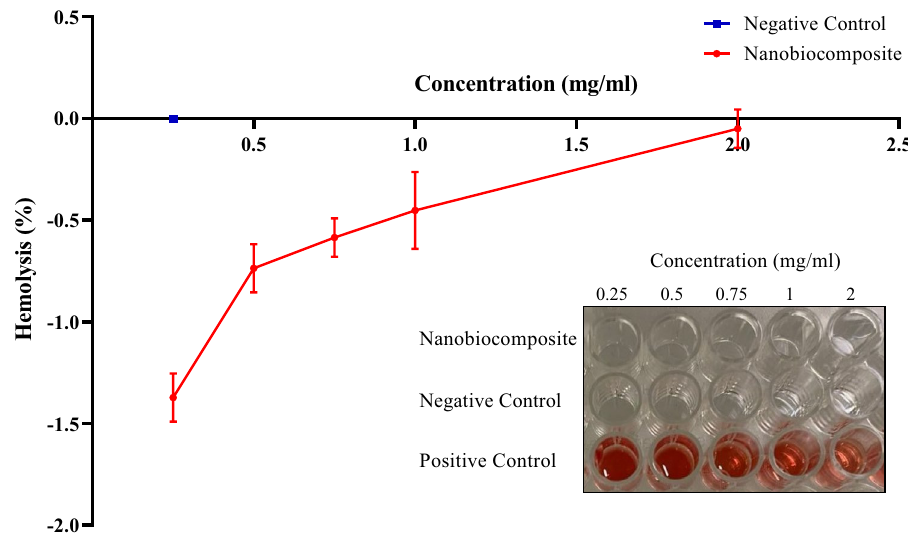
Figure 4. Hemolysis histogram of SA hydrogel/SF/HNTs/Fe 3 O 4 nanobiocomposite, comes with 96-well plate